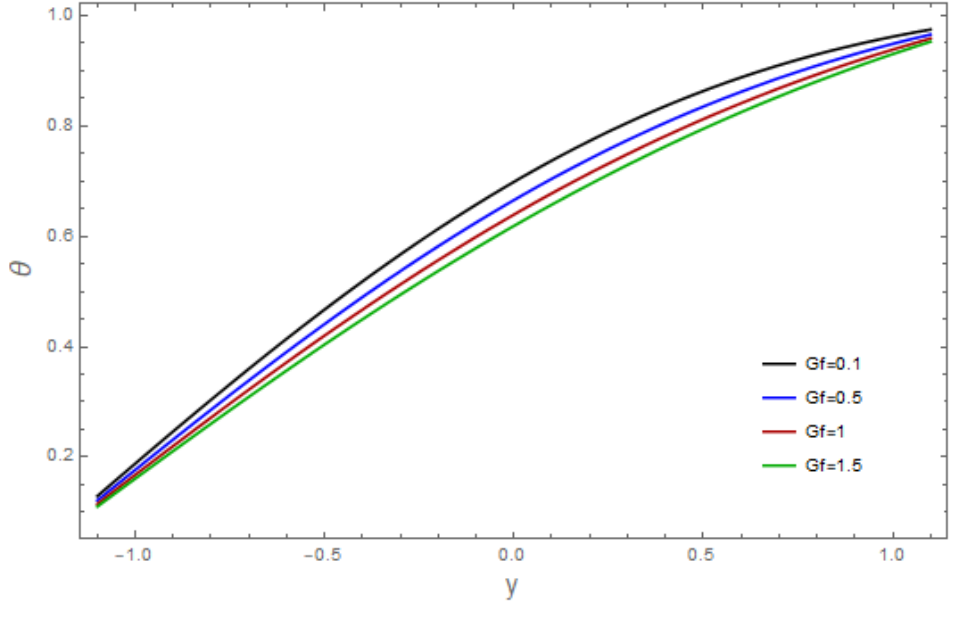
Figure 9. Effect of 𝐺𝑓 on 𝜃 .